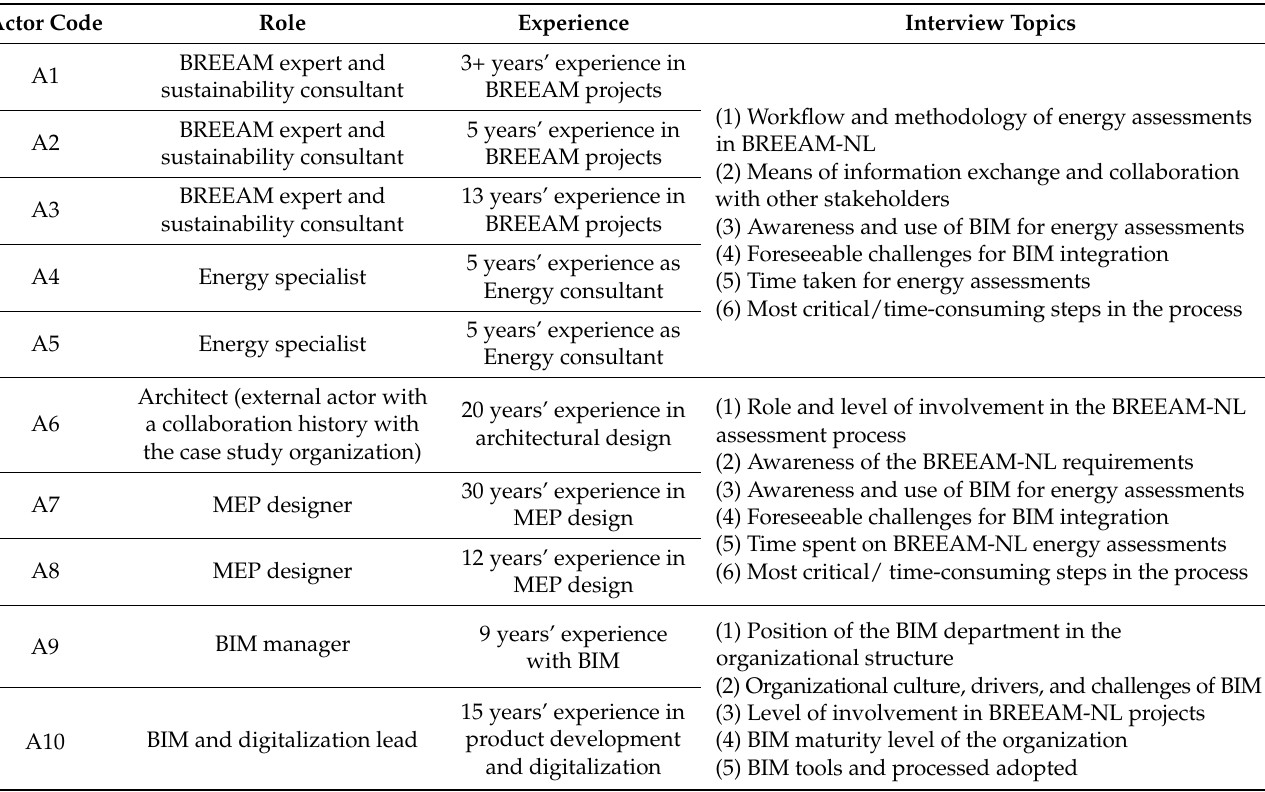
Table 3. List of interviewees and topics